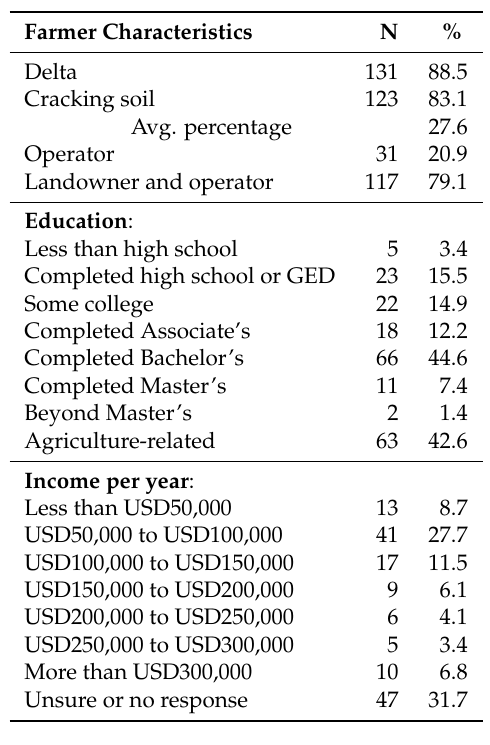
Table 1. Summary statistics of farmer characteristics from an irrigation survey conducted in the Mississippi Delta in